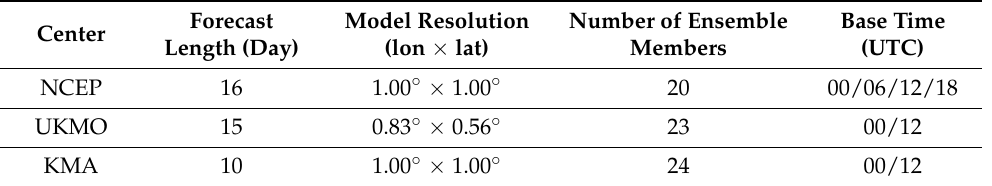
Table 2. Characteristics of the NWP models used in this